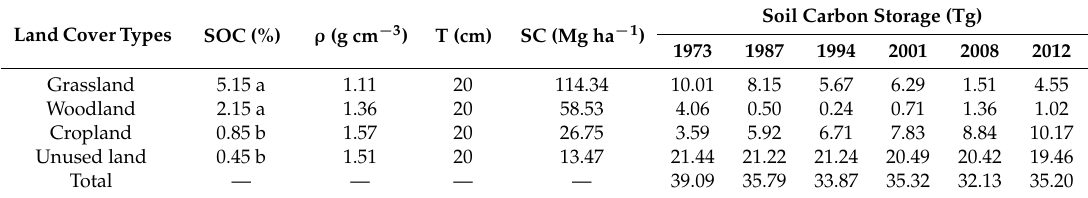
Table 1. Soil carbon storage in the Shiyang River Basin from 1973 to 2012.